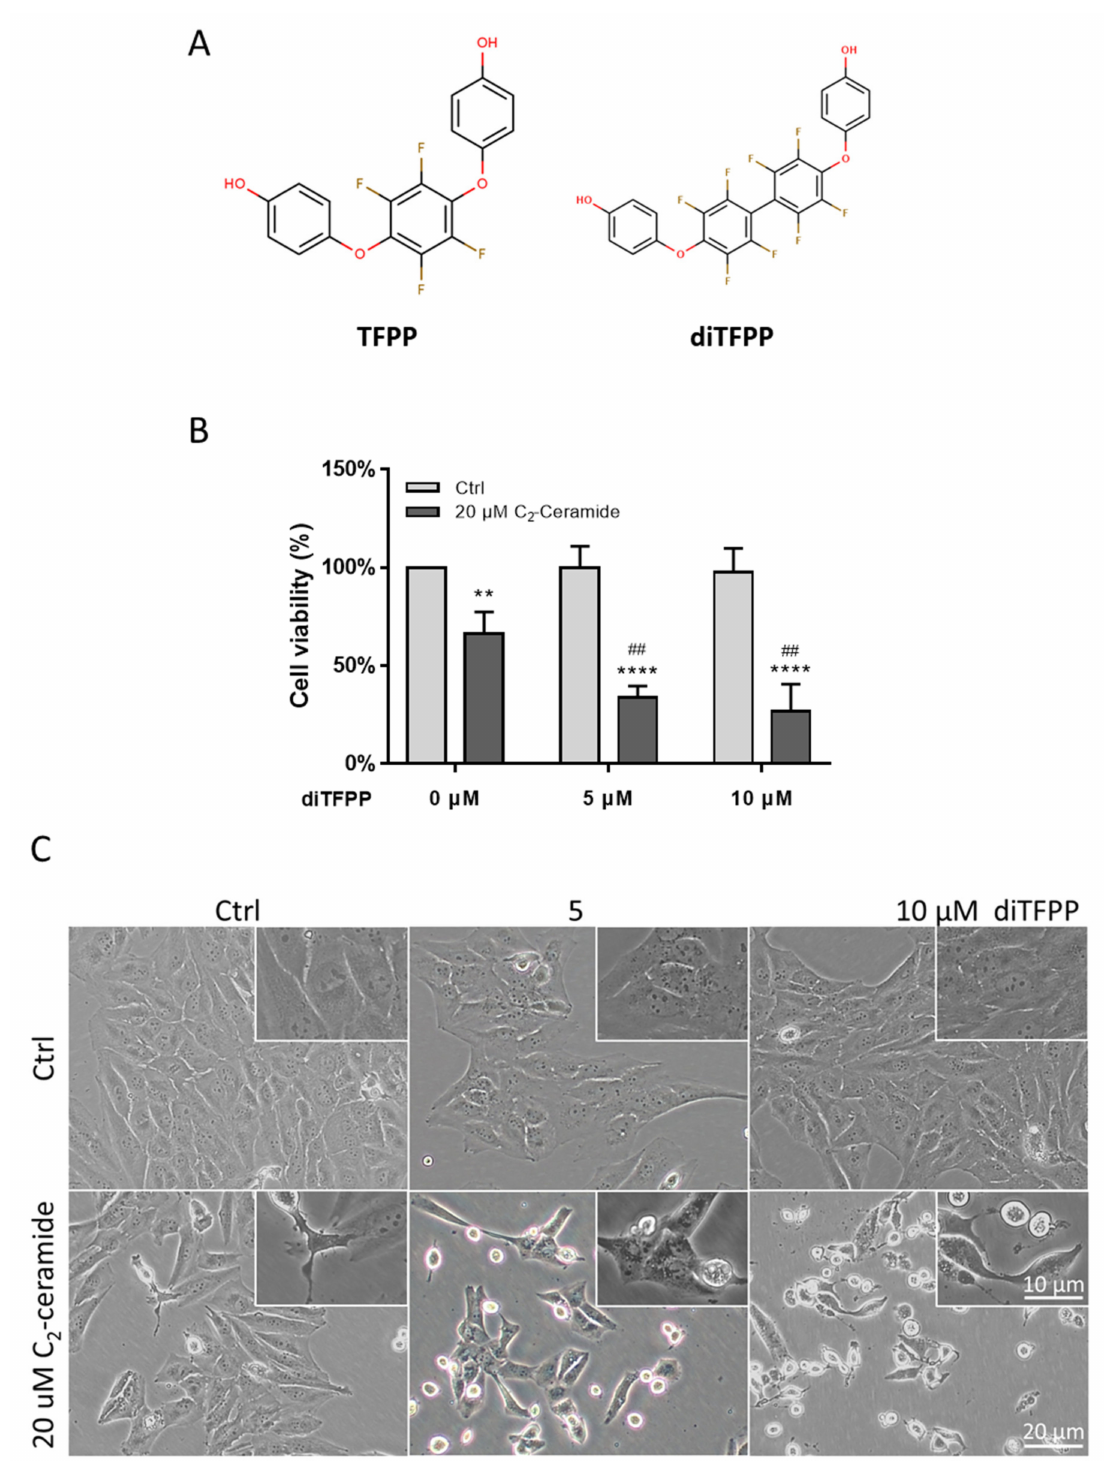
Figure 1. diTFPP and C 2 -ceramide cotreatment induced cell death of HCC cells. ( A ) The structure of phenoxy phenol compounds, TFPP, and diTFPP. ( B ) Cell viability of HA22T cells after diTFPP and/or C 2 -ceramide treatment for 24 h. n = 3, ** p < 0.01, **** p < 0.0001 compared with the control and 0 µ M diTFPP groups. ## p < 0.01 compared with the C 2 -ceramide with no diTFPP treatment group; all data are presented as the mean ± SD of three independent experiments. ( C ) HA22T cell morphology after C 2 -ceramide and/or diTFPP treatment for 24 h. Magnification: 100 ×